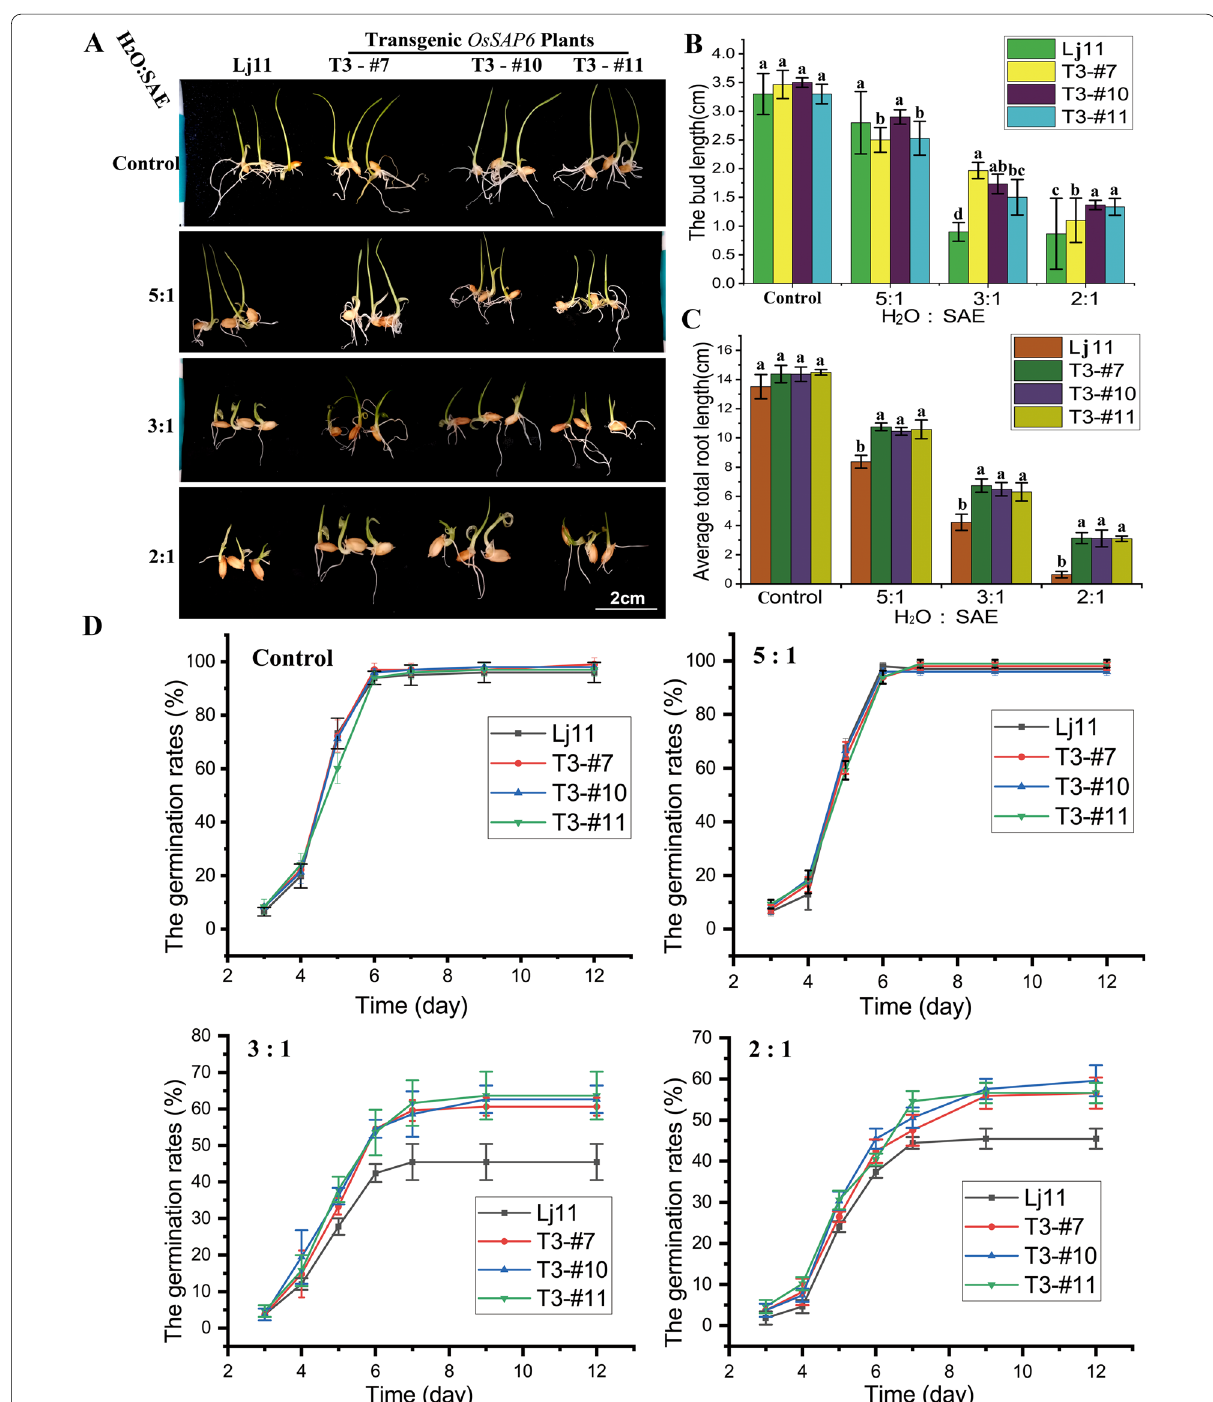
Fig. 3 Overexpression of OsSAP6 in rice enhanced tolerance to soda saline–alkaline stress during germination period. A Germination phenotypes of OsSAP6 overexpression lines (T3-#7, 10, and 11) and Lj11 under different concentrations of SAE stress (H 2 O:SAE control). B bud length; C total root length; D germination rate. Data show the mean genotype were measured in each replicate. Statistical differences are labeled with different letters using LSD test ( p < 0.05, one-way